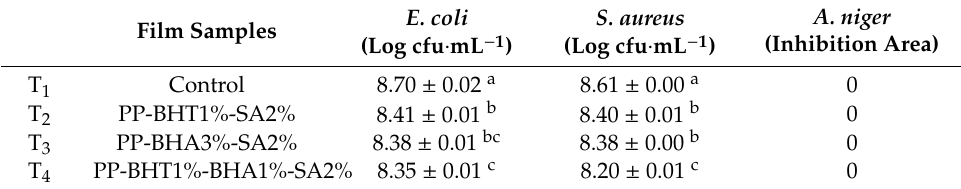
Table 1. The results of the antimicrobial properties of PP-based active films. Film Samples